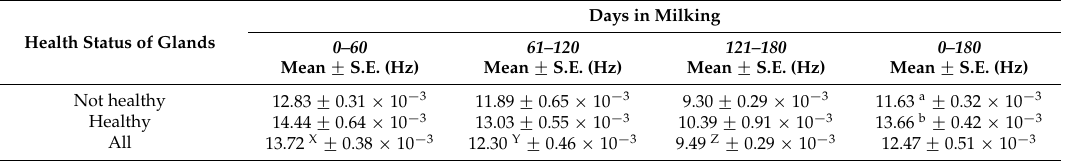
Table 10. Overall means and standard errors (S.E.) of the frequency of the first most representative spectrum peak (FFT_P 1 ), according to mammary gland health status and lactation stages.